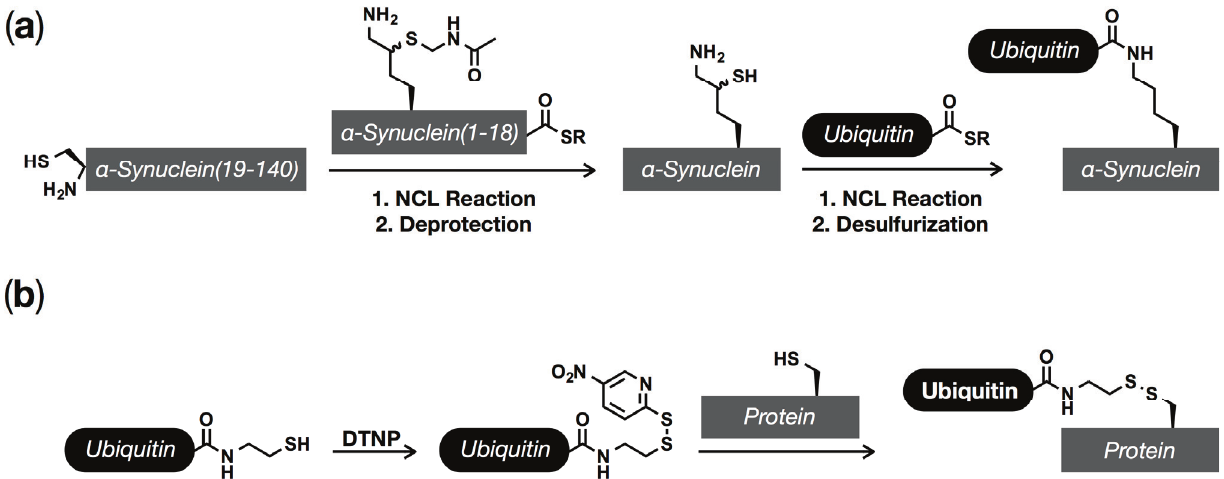
Figure 3. Chemical methods for the installation of ubiquitin and ubiquitin-like modifications. ( a ) Synthesis with (cid:5)-mercaptolysine. A synthetic peptide thioester containing a protected (cid:5)-mercaptolysine is reacted with a recombinant protein fragment to generate full-length (cid:2)-synuclein. After deprotection of the (cid:5)-mercaptolysine residue, it can be selectively reacted with a recombinant ubiquitin thioester. Desulferization then gives site-specifically ubiquitination (cid:2)-synuclein with no mutations. ( b ) Disulfide-directed ubiquitination. A C-terminal ubiquitin thiol, produced using intein chemistry, can be activated as a mixed disulfide, which can then be transferred to a cysteine residue on